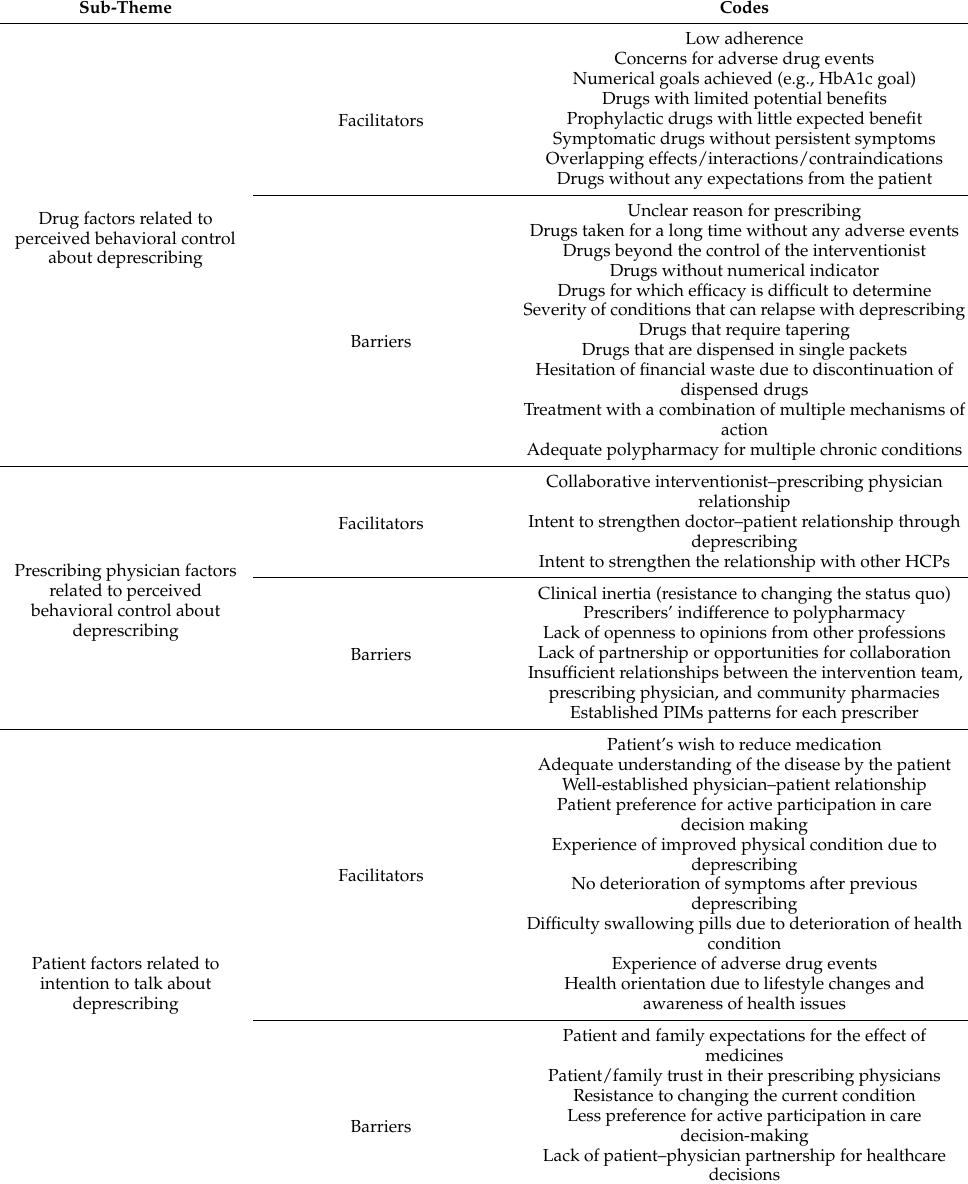
Table 2. Facilitators and barriers affecting healthcare professional’s perception and